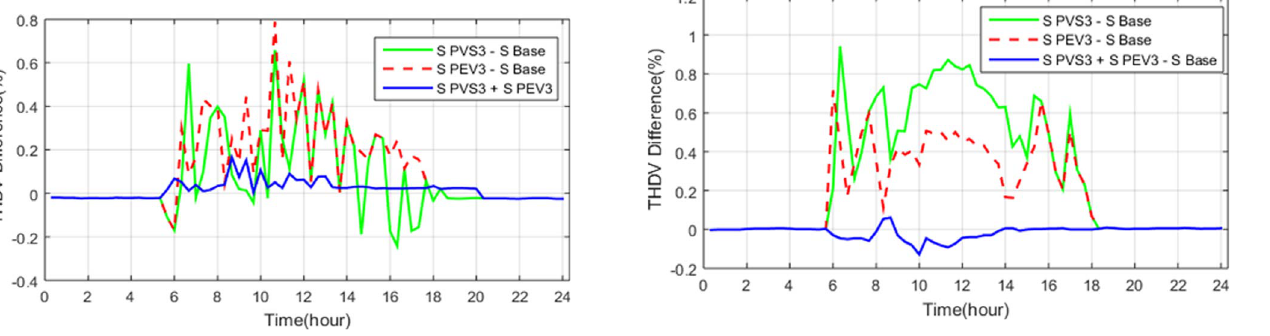
Figure 15. Analysis of daily pro fi les of THD when zero medium voltage grid and PEV harmonic compared to base case.